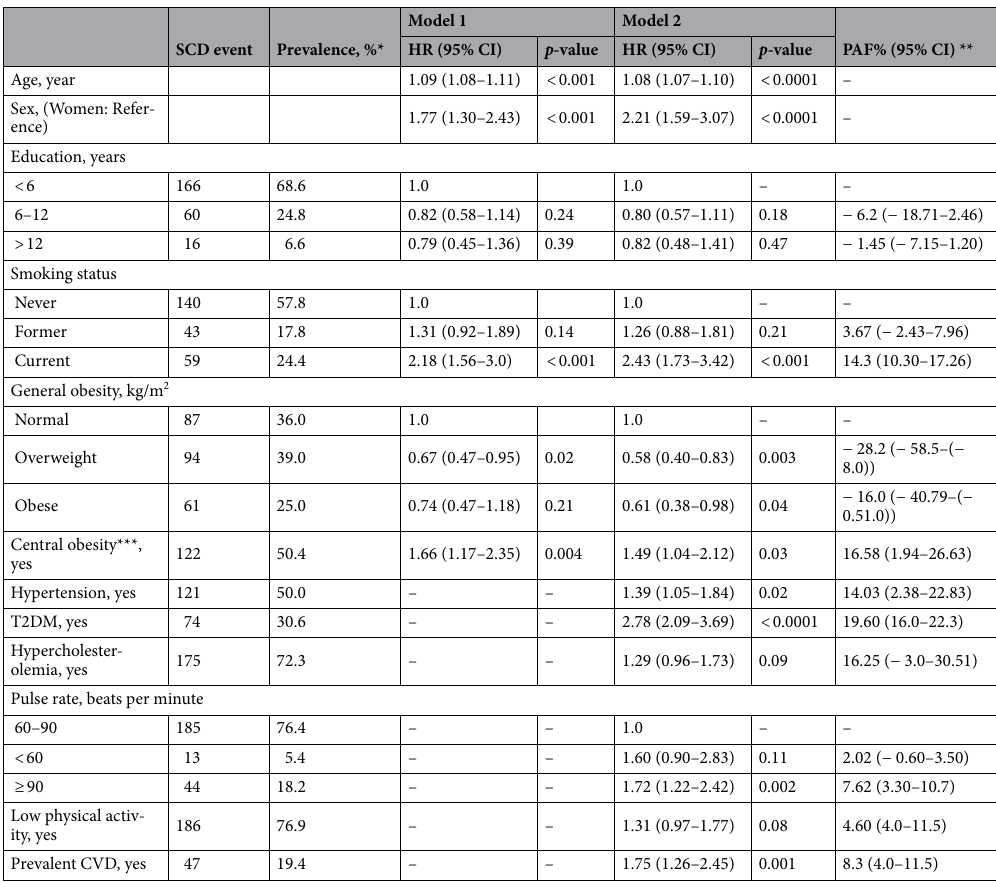
Table 2. Hazard ratios (HR) and 95% confidence intervals (CI) from the multivariable analysis of categorical potential risk factors for SCD incidence: Tehran Lipid and Glucose Study (1999–2018). SCD sudden cardiac death, T2DM type 2 diabetes mellitus, CVD cardiovascular disease. Model 1: Adjusted with Age, Sex, Education, Smoking status, General obesity and Central obesity. Model 2: Adjusted with, T2DM, hypertension, hypercholesterolemia, resting heart rate, low physical activity and prevalent CVD in addition to model1 risk factors. *The prevalence of SCD event among participants with outcome of interest. **PAF: Population Attributed Fractions determined by following formula: Prevalence × ((Hazard ratio-1)/Hazard ratio) × 100. ***Central obesity in this table defines as high waist circumference (WC ≥ 95